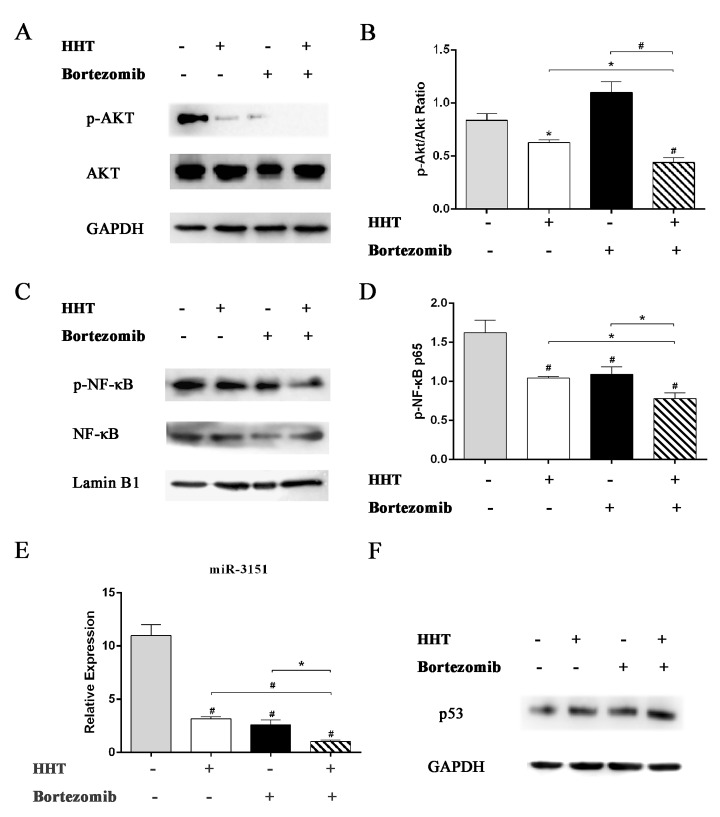
Effects of HHT or Bortezomib on Akt and NF-κB signaling pathway.Western blot analyses of p-Akt, Akt (A and B), p-NF-κB, NF-κB (C and D) and p53 (F) protein expression in SKM-1 cells exposed to 11.55 nM HHT or 1.12 nM Bortezomib for 72 h. (E) Real-time PCR detection of miR-3151 expression level in SKM-1 cells exposed to 11.55 nM HHT or 1.12 nM Bortezomib for 6 h. *P < 0.05, #P < 0.01 vs untreated control.